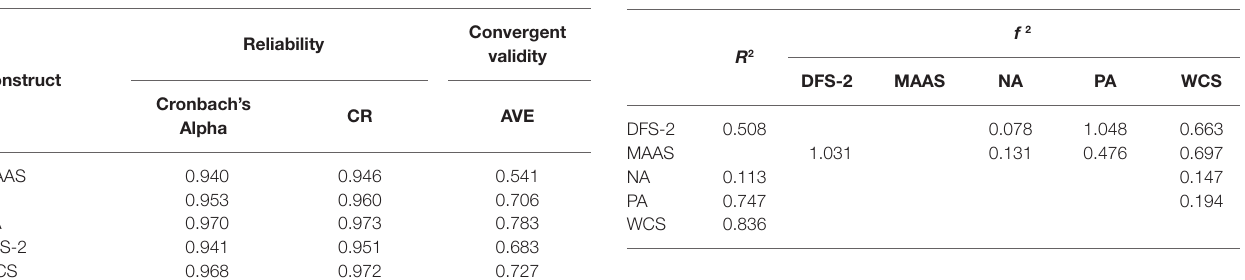
TABLE 6 | Theoretical effect sizes for R 2 and f 2